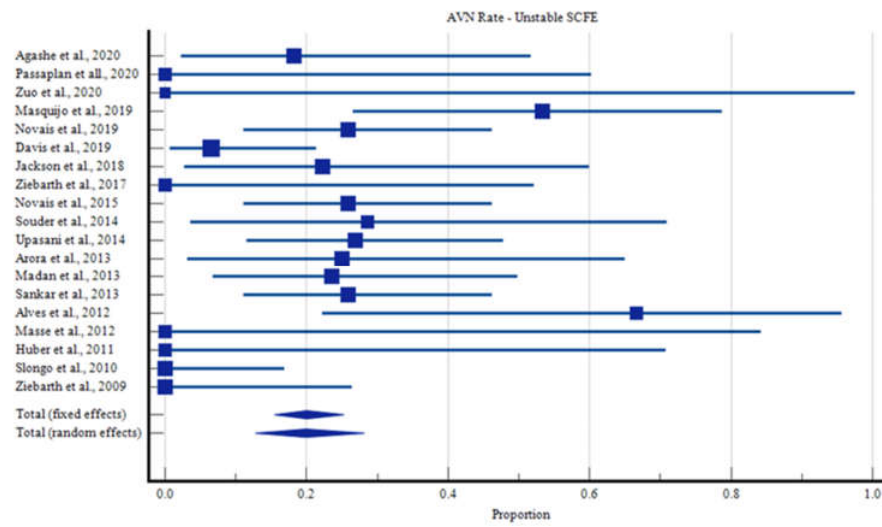
Figure 4. Rates of Avascular Necrosis in Unstable SCFE Cases.